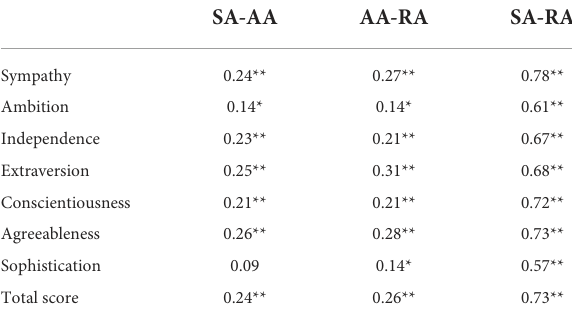
TABLE 2 Correlations among the three types of